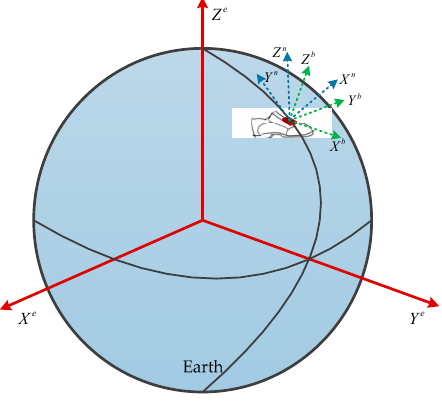
Figure 1. The reference frames.